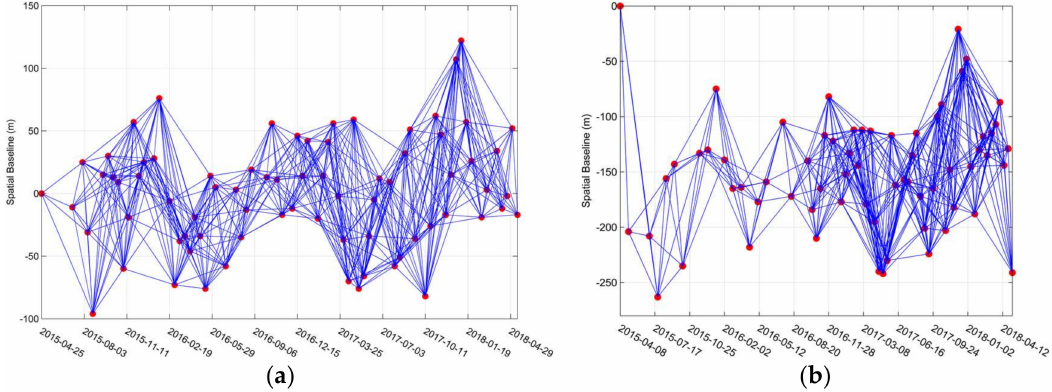
Figure 6. Spatial and temporal baselines of the Sentinel-1 datasets: Track 01 ( a ) and Track 02 ( b